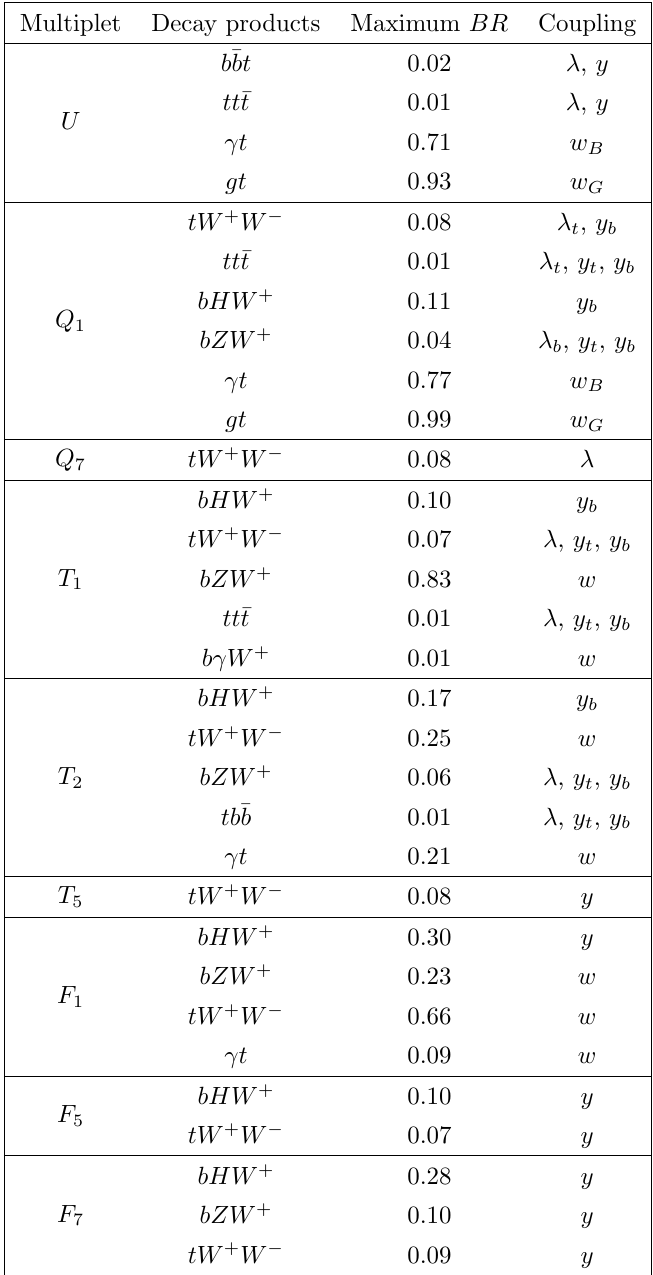
Table 8 . Extra decay channels of T with branching ratio larger than 0.01 for M = 2 TeV, when the couplings (cid:21) are (cid:12)xed to the values that saturate electroweak precision limits. The last column displays the coupling constant which, when set to (2 TeV) (cid:0) 1 , gives the maximum BR in the corre- sponding channel. The appearance of (cid:21) indicates that the channel in question is present already in the case with dimension-4 interactions only.